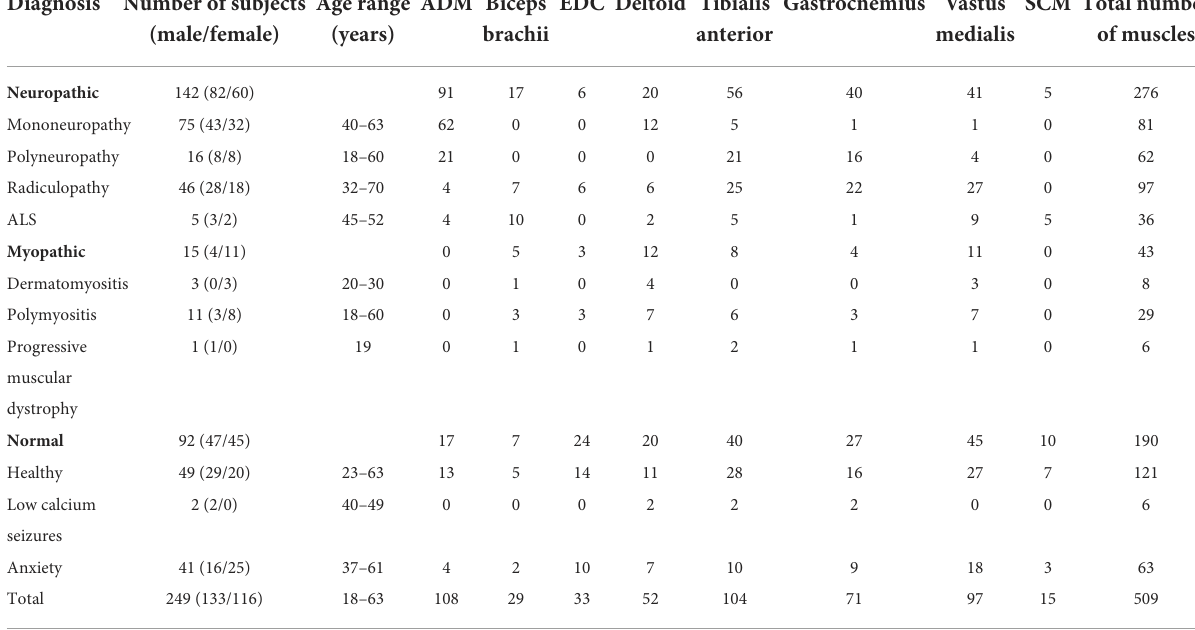
TABLE 2 Clinical diagnosis and the number of muscles sample. Diagnosis Number of subjects Age range ADM Biceps EDC Deltoid Tibialis Gastrocnemius Vastus SCM Total